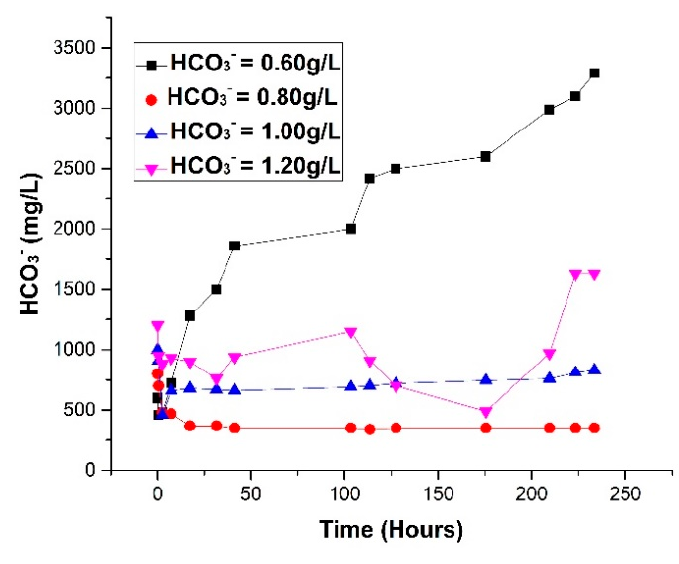
Figure 4. Change in HCO 3 − concentration in the leaching solution.